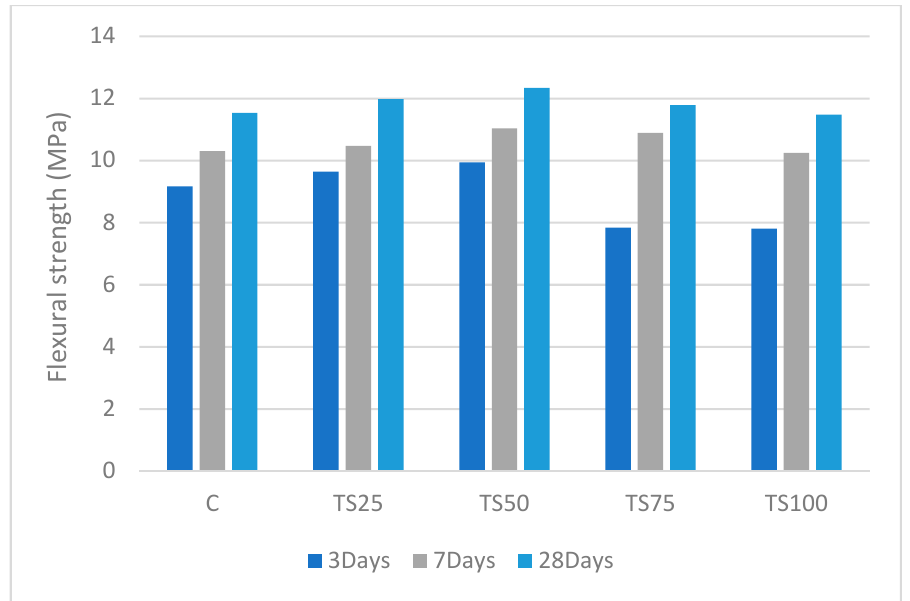
Figure 15. Flexural strength of mortars with a w / c of 0.55 at 3, 7, and 28 days of curing.